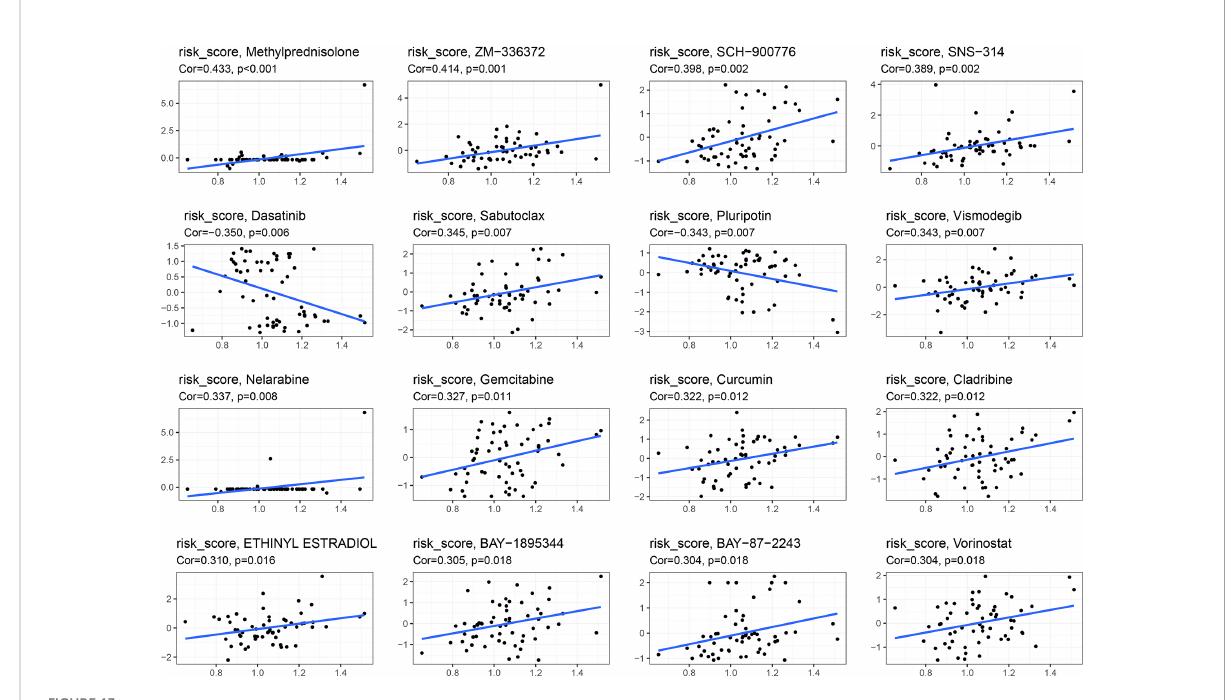
FIGURE 13 Association between this signature and drug